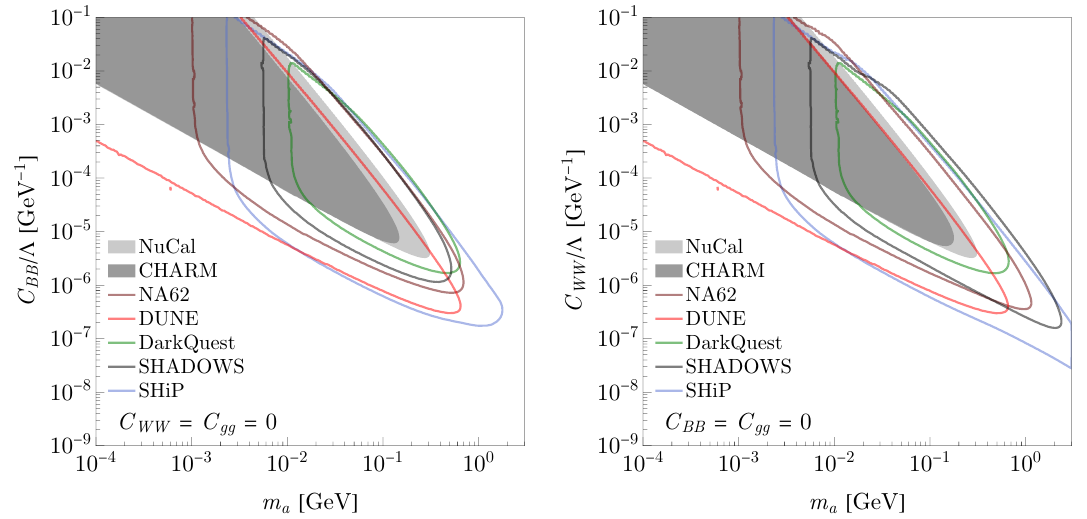
Figure 5 . 90% CL exclusions limits for scenarios (i) (left) and (ii) (right). The exclusion from past experiments which accounts for signal and background studies is indicated by a full contour while the future experiments, assuming a zero background hypothesis, are indicated by a corresponding